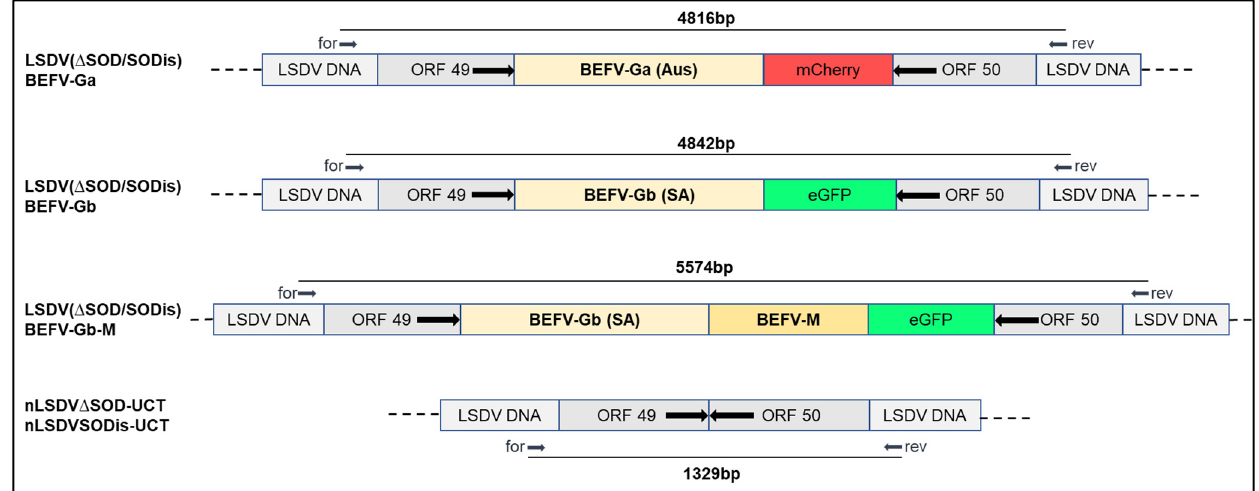
Figure 2. Diagrammatical representation of six dual LSDV-BEFV candidate vaccines constructed. The foreign gene cassettes were inserted into either nLSDV ∆ SOD-UCT or nLSDVSODis-UCT, between LSDV ORFs 49 and 50. A BEFV G protein sequence was derived from an Australian isolate (Ga) or a South African consensus sequence (Gb). M = Matrix protein gene; mCherry and eGFP encode red and green fluorescent marker proteins, respectively. The positions of primer binding sites (for = forward and rev = reverse) are shown, as well as the PCR product sizes amplified from these primers.